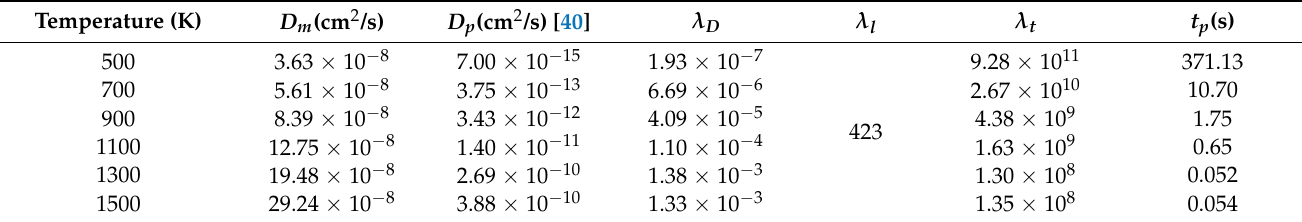
Table 5. Scale ratios at different temperatures for similitude analysis.